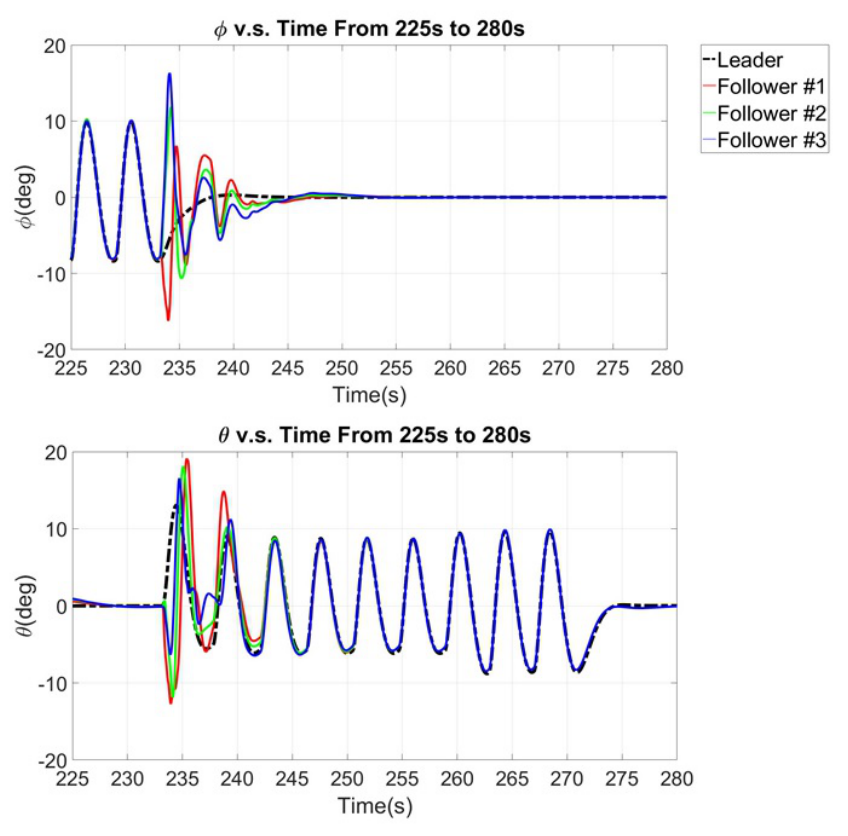
Figure 21. Responses of pitch and roll angles from 255 to 280